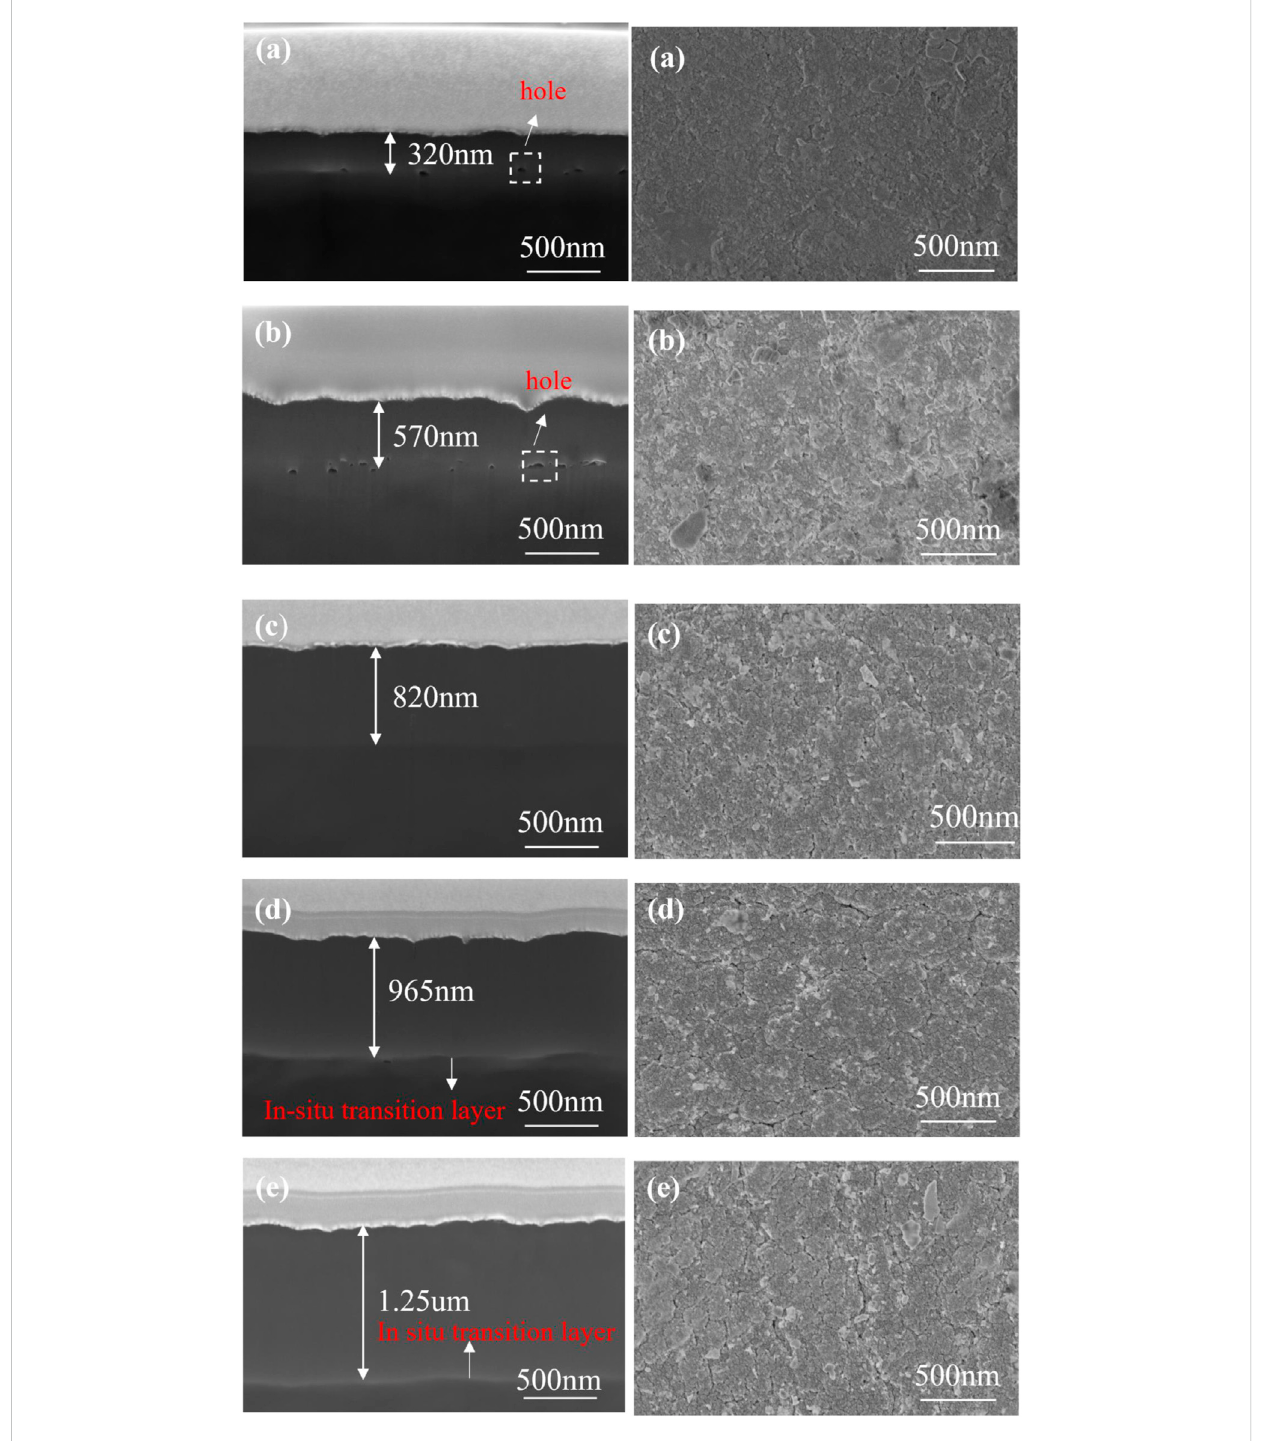
FIGURE 3 Surface and cross-sectional morphologies of PI surface treated by carbon plasma with different graphite target currents: (A) 1.0 A; (B) 1.5 A; (C) 2.0 A; (D) 2.5 A; (E) 3.0 A.